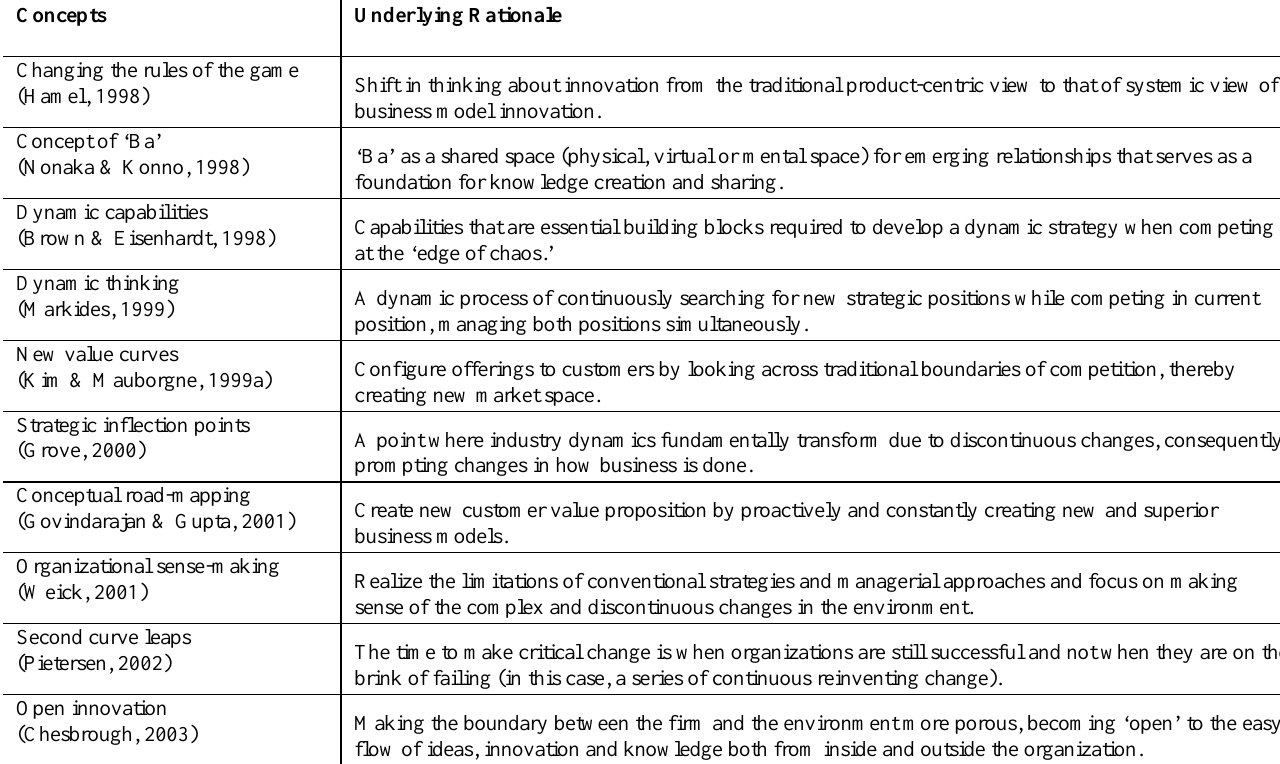
Table 1: Recent business innovation concepts and the underlying rationale of mental space